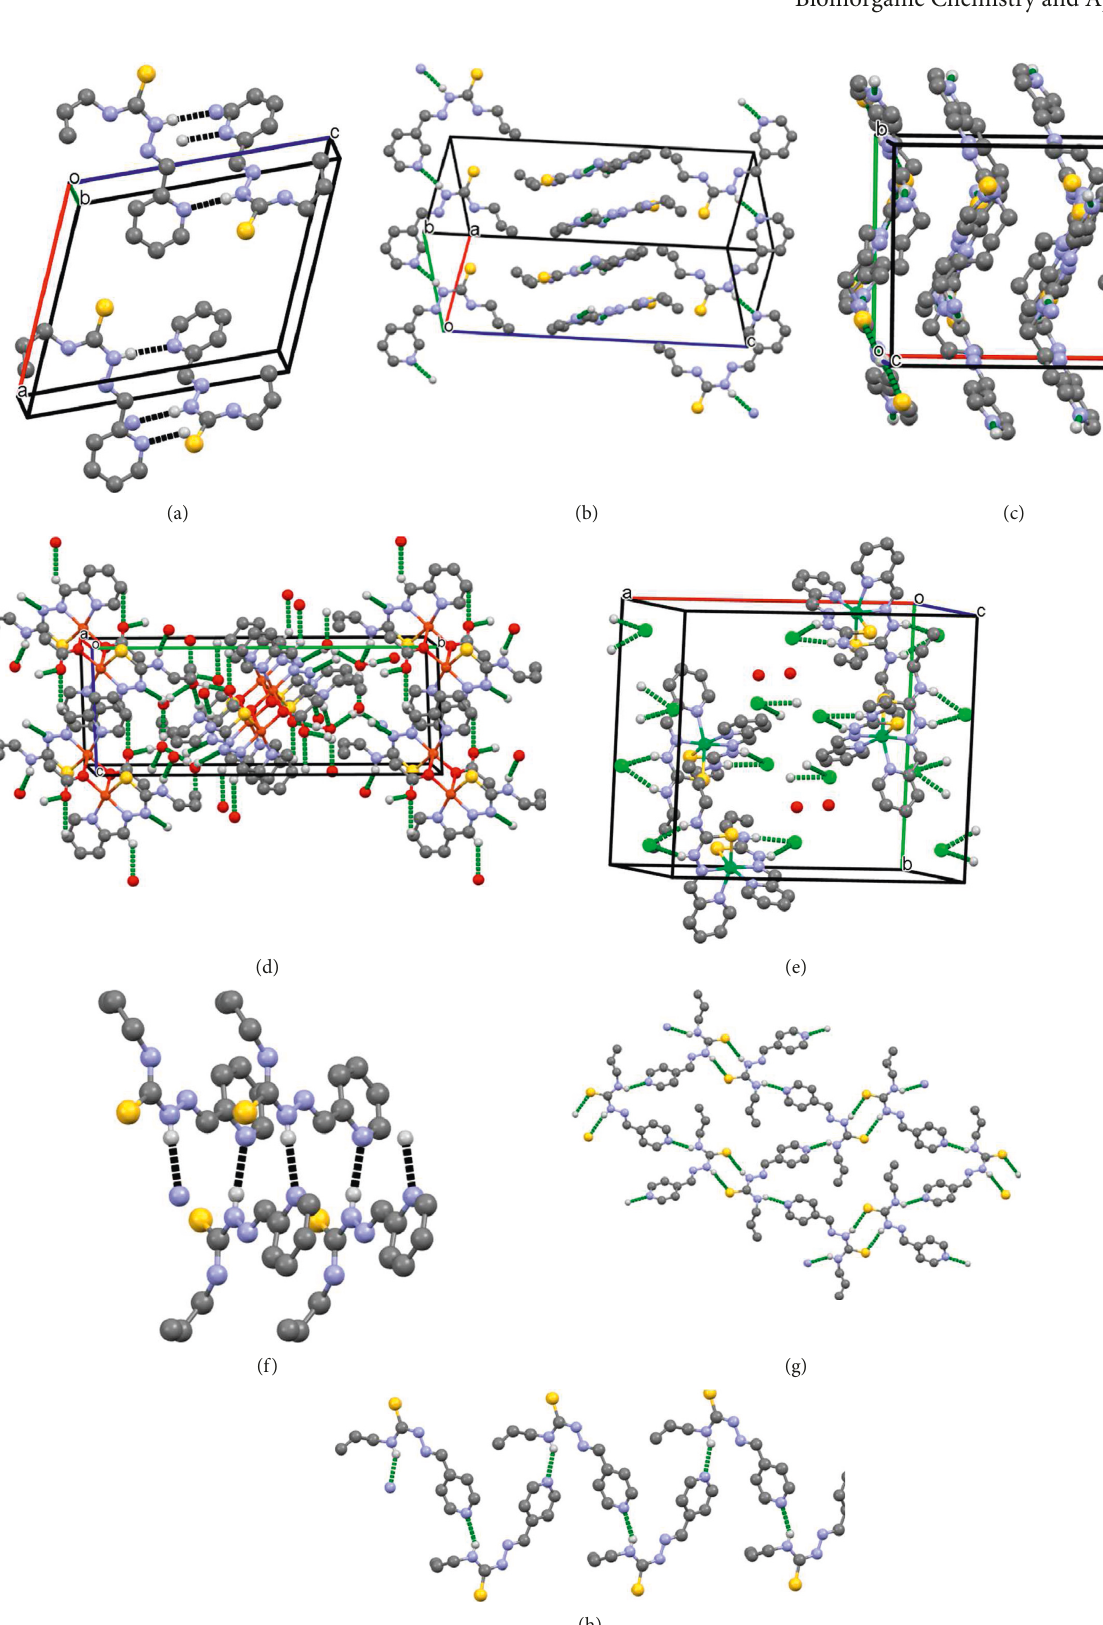
Figure 2: The crystal packing fragments of (a) HL (b) HL a , (c) HL b , (d) 4 , (e) 5 , (f) chains in HL , (g) layers in HL b , and (h) chains in HL b